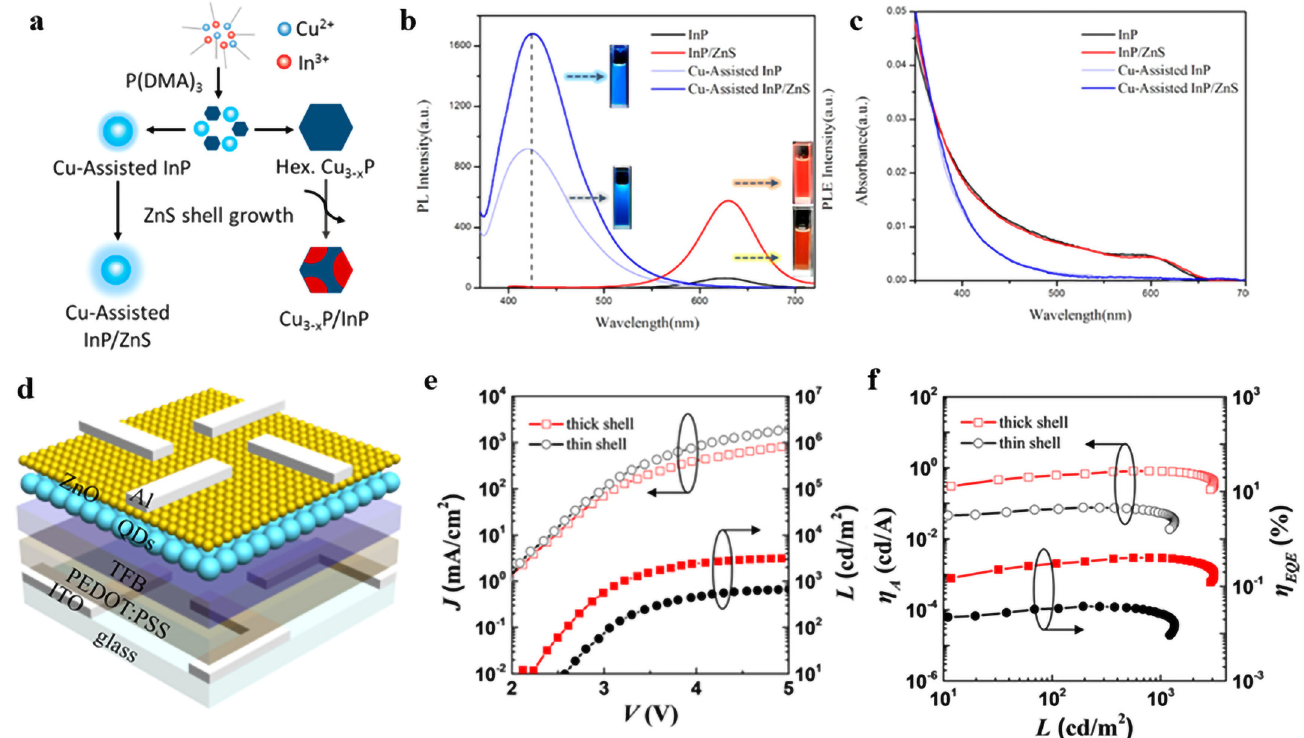
Figure 8. ( a ) Schematic synthesis of blue-emitting InP/ZnS QDs with Cu − assisted process. ( b ) UV − Vis absorption and ( c ) photoluminescence emission spectra of InP and InP/ZnS QDs, Cu − assisted InP QDs, and Cu − assisted InP/ZnS core/shell QDs. Reprinted with permission from Ref. [49]. © 2019, American Chemical Society. ( d ) Schematic diagram of the QLEDs structure. ( e ) Variations of current density and luminance as a function of the voltage. ( f ) Current efficiency and EQE as a function of the luminance. Reprinted with permission from Ref. [85]. © 2020, American Chemical Society.